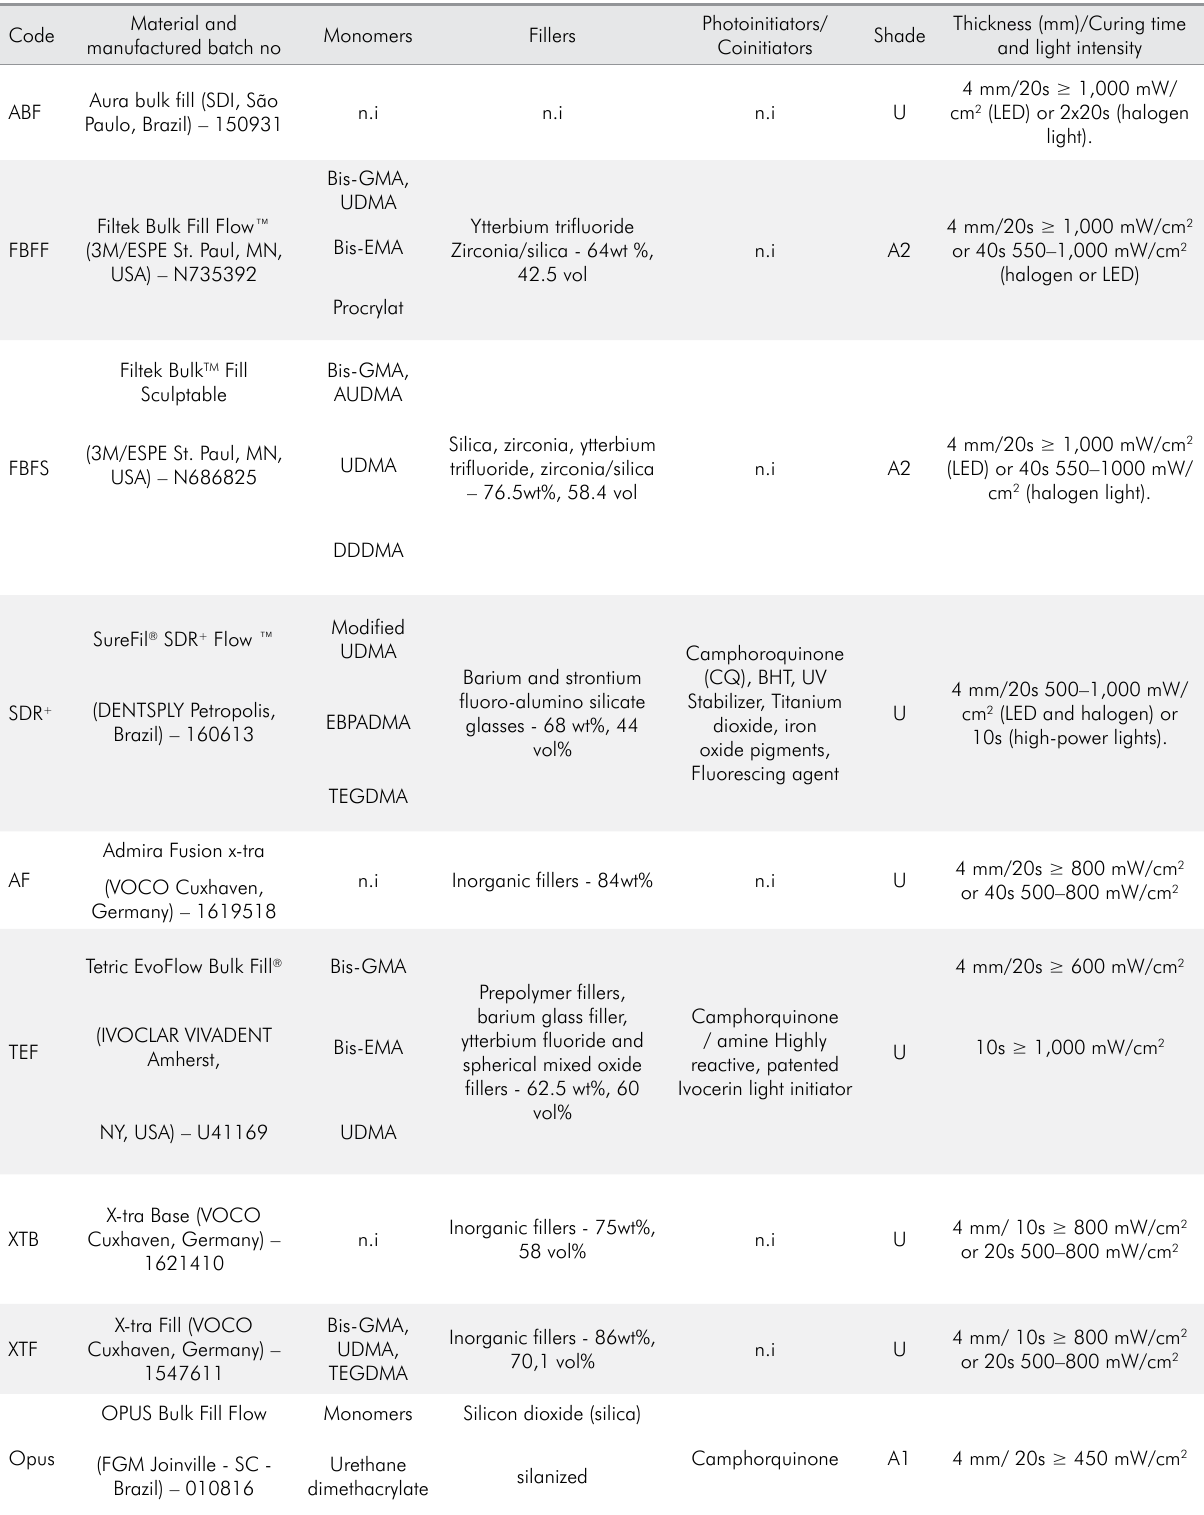
Table 1. Test materials and manufacturer’s